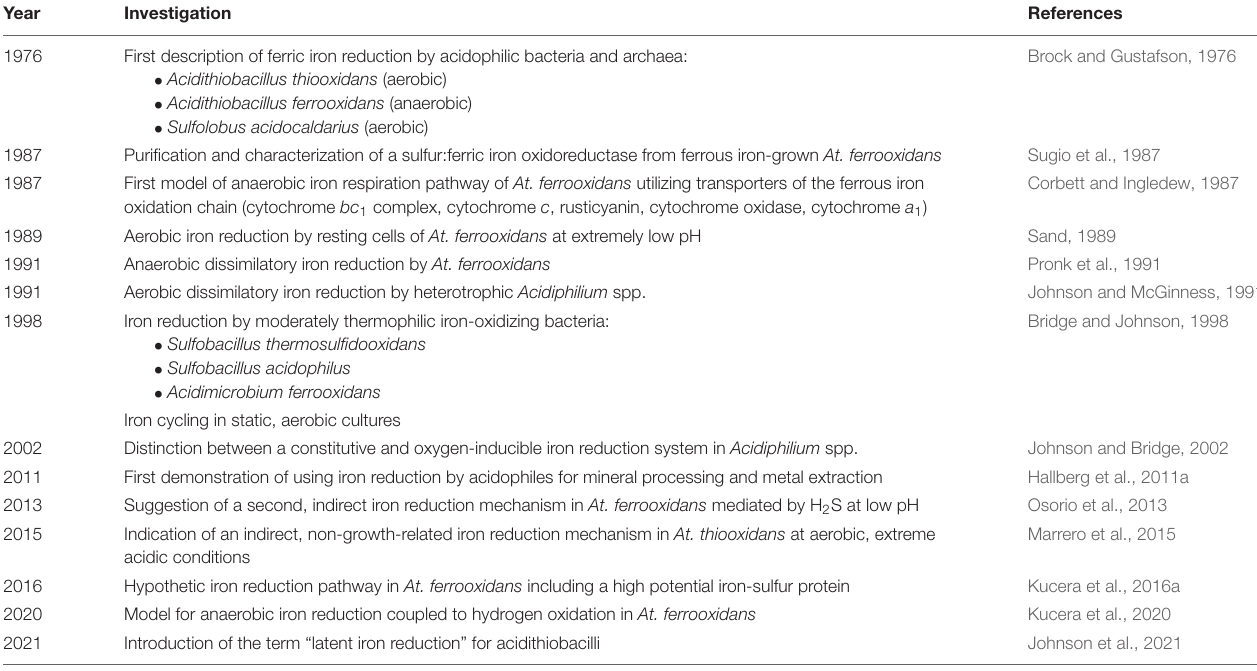
TABLE 1 | Most important discoveries during research of iron reduction in